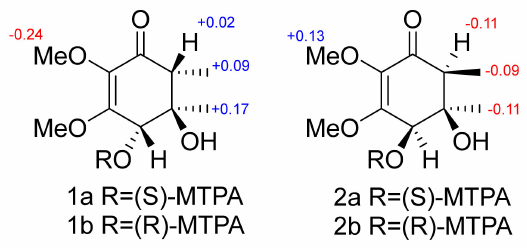
Figure 4. ∆ δ ( δ S - δ R ) values (in ppm) for MTPA esters of 1 and 2